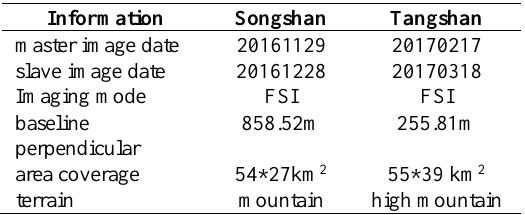
Table 2. The information of the experimental data